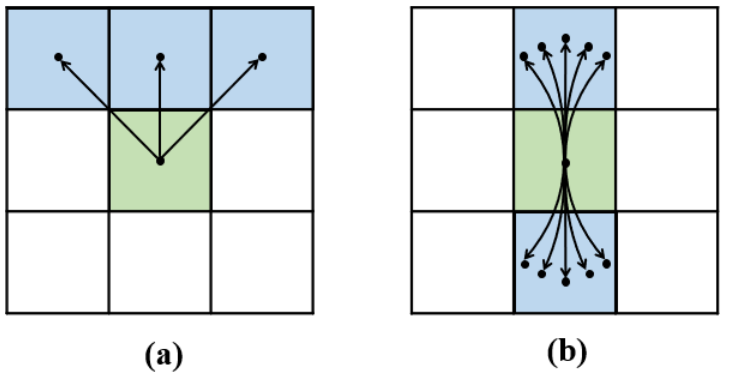
Figure 10. Node expansion diagram: ( a ) A* node expansion; ( b ) hybrid A* node